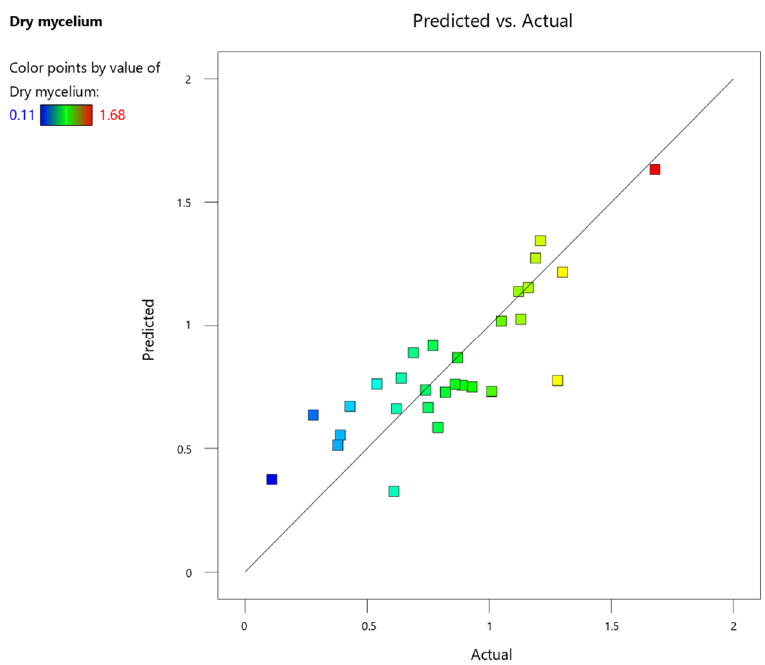
Figure 3. The predicted against actual results of dry mycelium weight (g/500 mL).